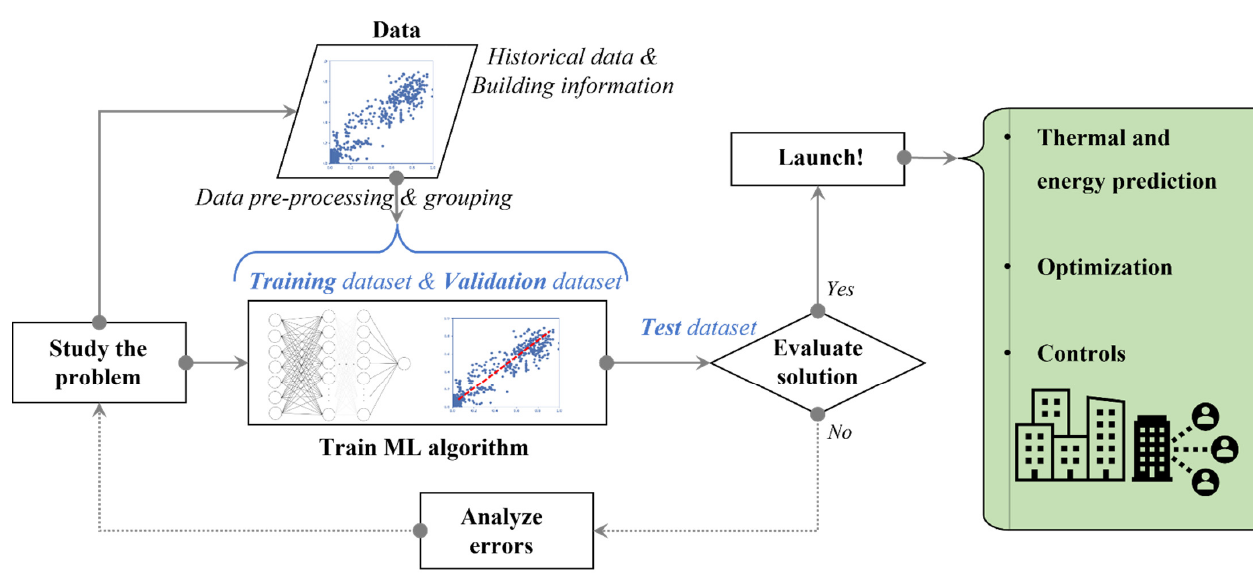
Figure 4. Schematic of a typical machine learning-based “black-box” model approach [121].